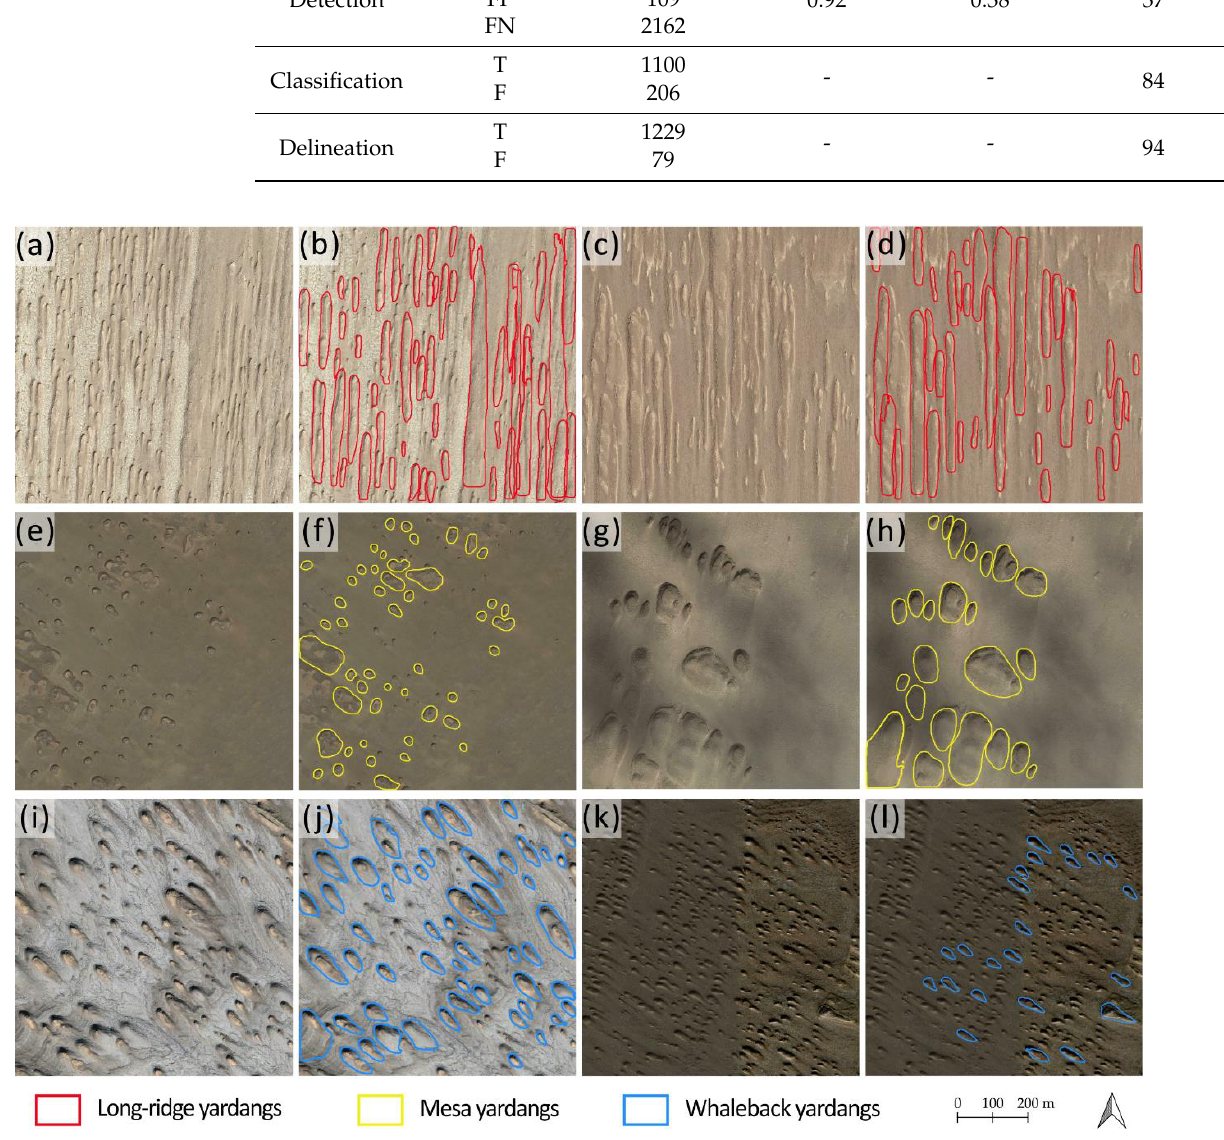
Figure 7. Example delineation and classification results on 2.0 m images. (a,c,e,g,i,k): enlarged 2.0 m spatial resolution images with their locations marked in Figure 2. (b,d,f,h,j,l): corresponding characterization results by Mask R-CNN where long-ridge, mesa and whaleback yardangs are depicted using polygons with red, yellow and blue borders, respectively.